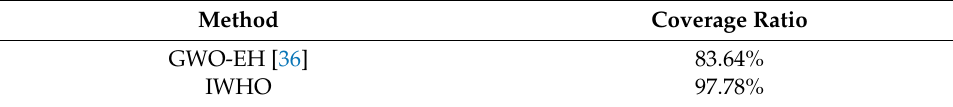
Table 12. Comparison of GWO-EH and IWHO experimental results.